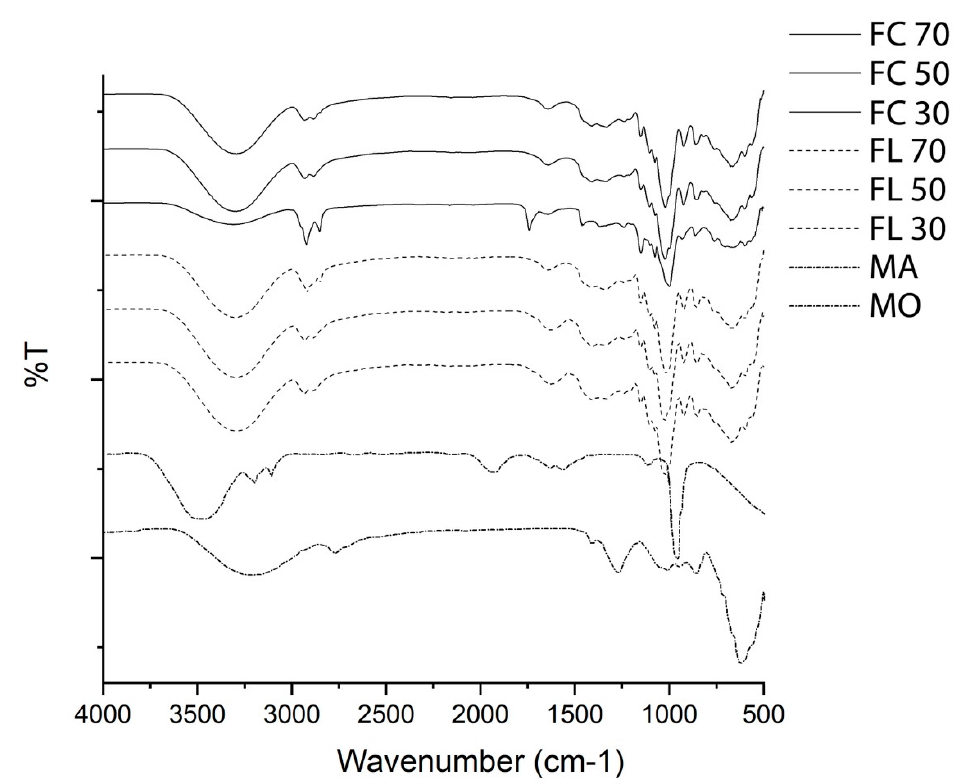
Figure 5. FTIR spectra of di ff erent LBMs obtained (MA: Aloe barbadensis Miller mucilage; MO: Opuntia ficus-indica mucilage. Table 5. Infrared absorption bands for the di ff erent